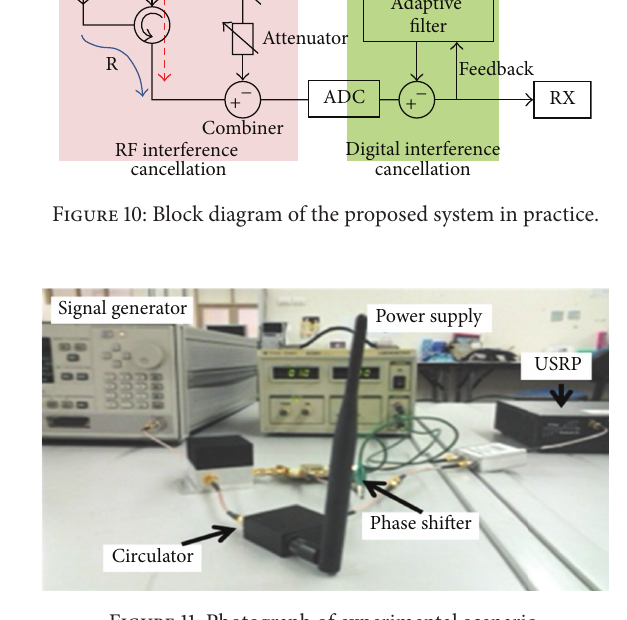
Figure 11: Photograph of experimental